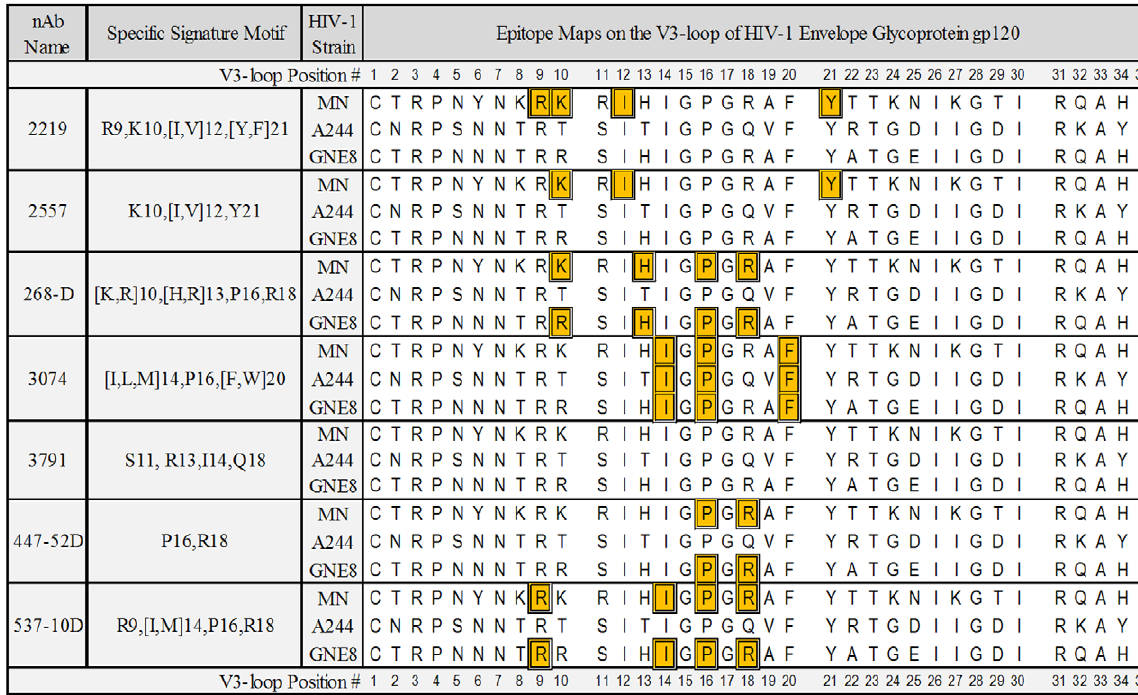
Figure 1. Library of signature motifs mapped to the V3 regions of AIDSVAX immunogens. Signature motifs recognized by each monoclonal antibody are shown in the second column: the numbers indicate the recognized positions in the V3 loop and the letters indicate the amino acid residues at each position required for recognition by that monoclonal antibody. Positions numbering is in the correspondence with the standard V3 loop numbering described elsewhere [19,20]. Colored rectangles in the sequence column indicate the amino acid residues composing the signature motif in each of the gp120s. Sequences without colored rectangles do not contain a given motif.